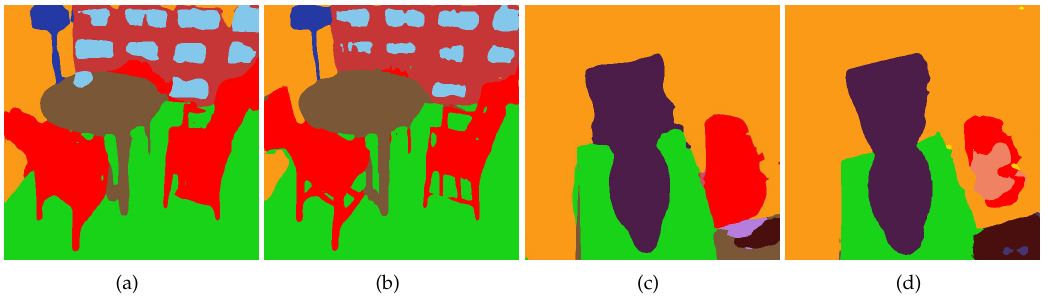
Figure 5. ( a , c ) are the coarse predictions from PixelNet, and ( b , d ) are the predictions after combining VoxelNet with PixelNet. It can be seen that the boundary shape is more accurate after the VoxelNet refinement. The colour palette can be found in Figure 6.